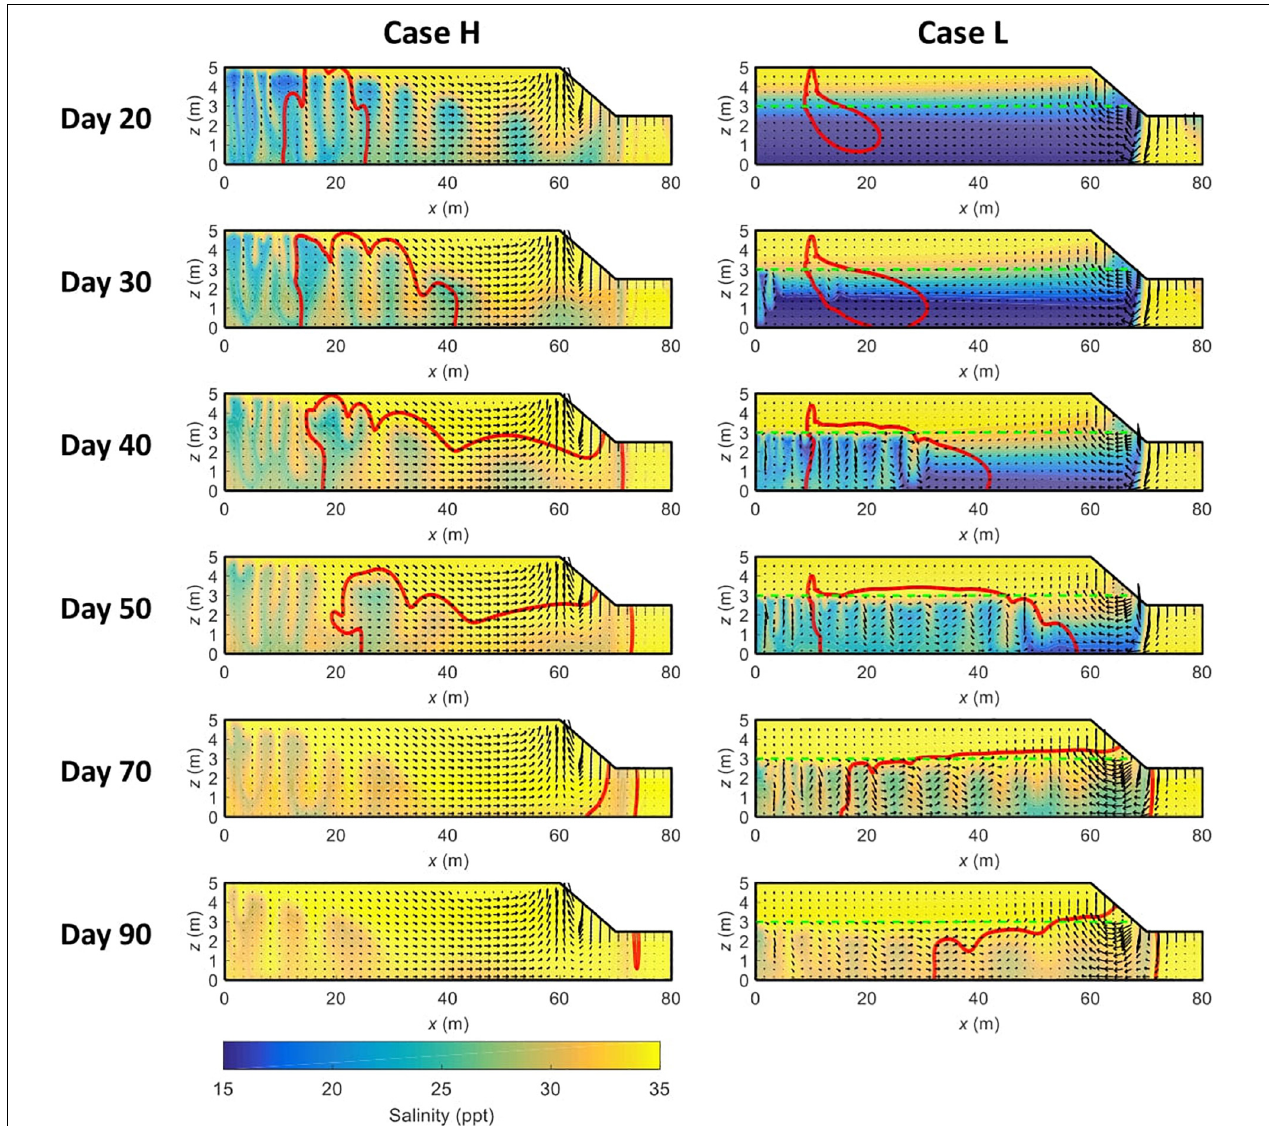
FIGURE 2 | Temporal variations of solute distribution contour line (in red, 0.0001 C 0 ) and pore water salinity distributions in Cases H and L. The green dashed line represents the boundary between the mud (upper) and sand (deeper) layers. All the plots show conditions at the mid-rising tide, with the arrows indicating the corresponding pore water flow